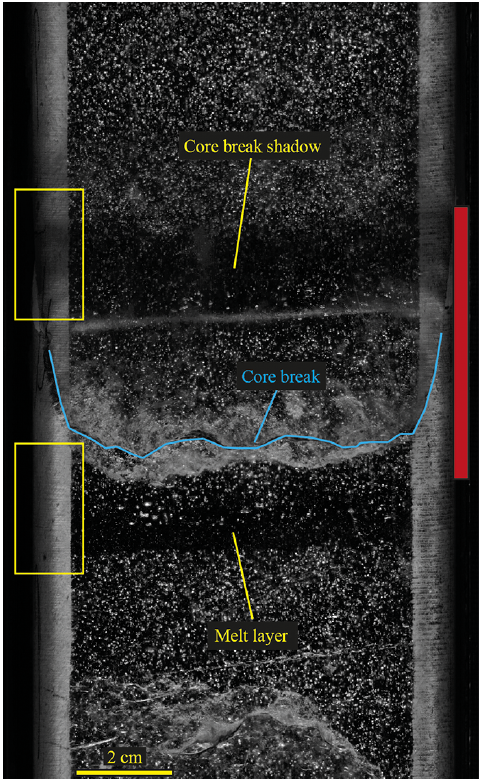
Figure 4. A core break casting a shadow and a melt layer have a very similar appearance in line scan images. A distinction is made based first on the proximity to the break and then on differences in brightness along the ice core’s round drilling edge (yellow boxes). Core break shadows darken the edge of the sample. The minimum section not suited for analysis is indicated by the red